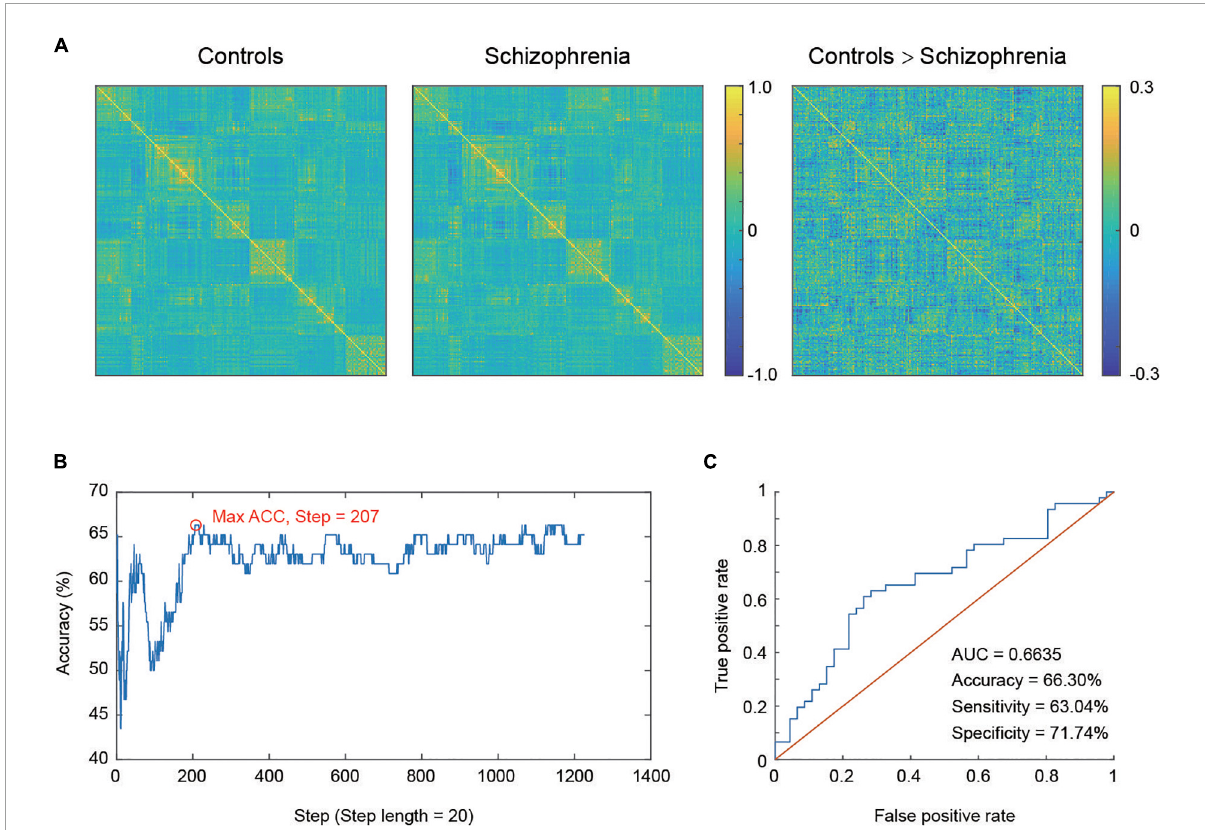
FIGURE1 (A) Task-modulated connectivity matrices for the schizophrenia group and healthy control group and different connectivity matrices between these two groups. (B) The classification accuracy for different steps, from 20 to 24,520 with a step length of 20, the maximum ACC was obtained at step 207, which corresponds to 4,140 features. (C) ROC curve of the classifier.